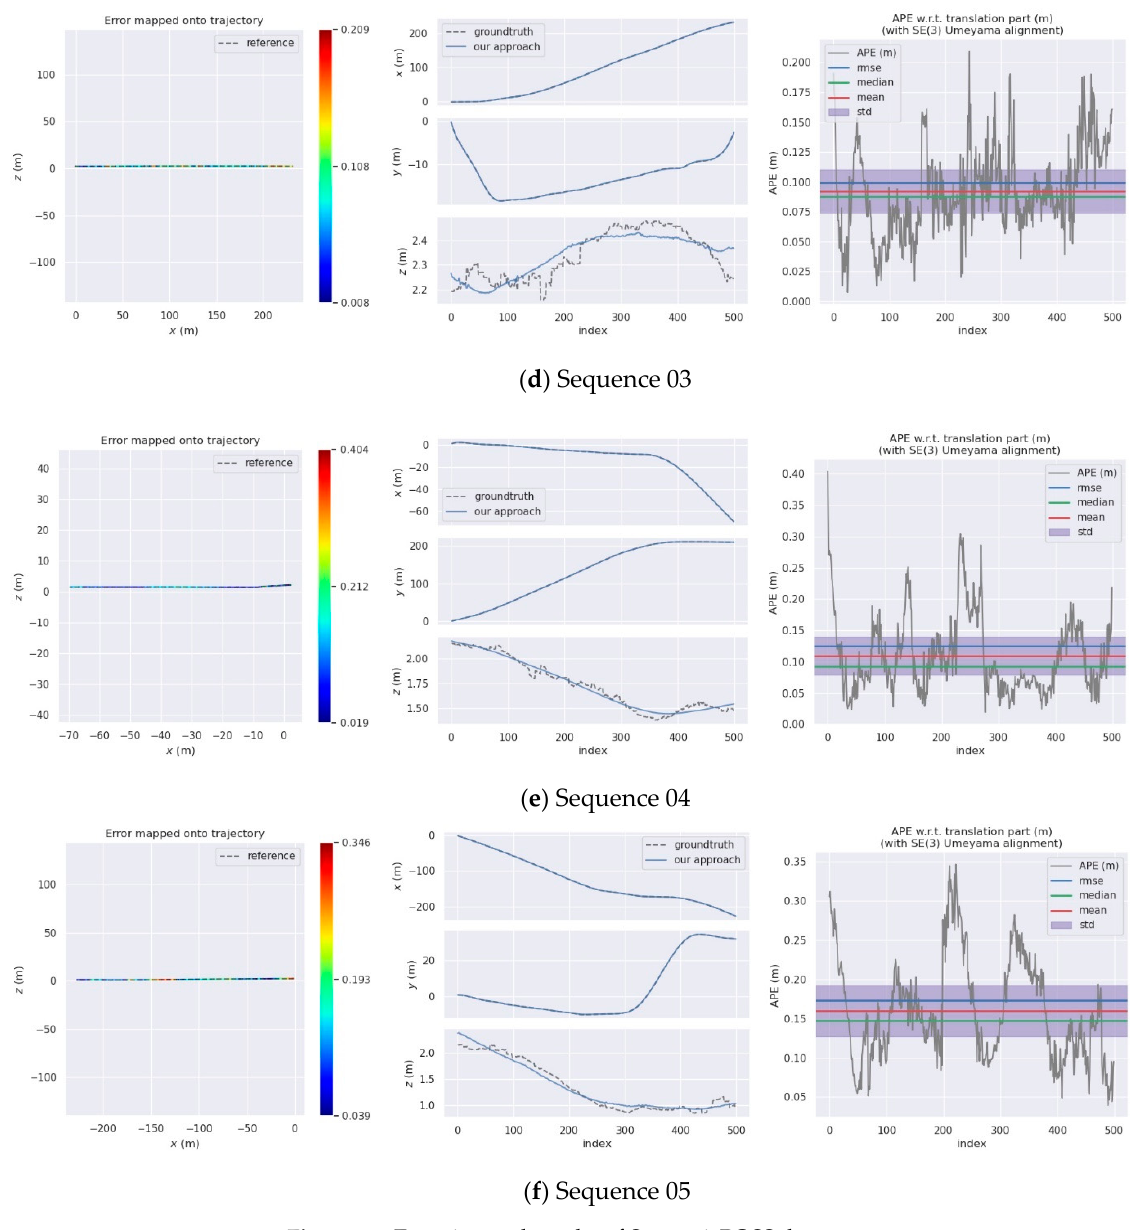
Figure 12. Experimental results of SemanticPOSS dataset.